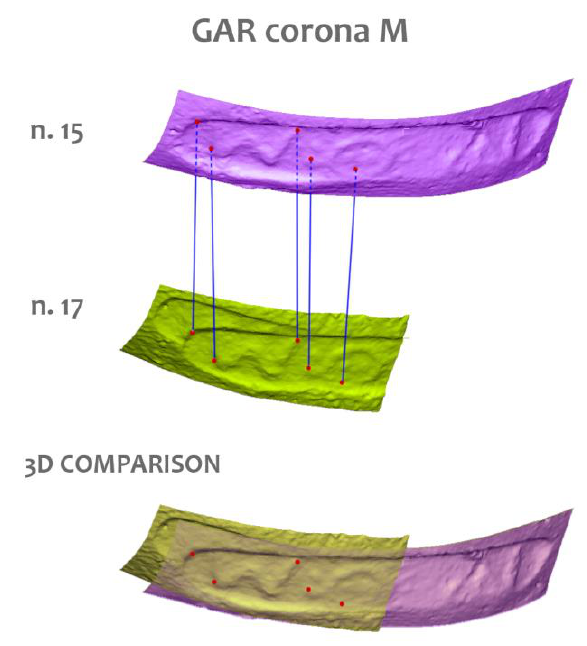
Figure 10 : Comparison of GAR crown M No. 15 and No. 17. Although No. 17 is only a fragment, the correspondence with No. 15 confirms that it belongs to the same